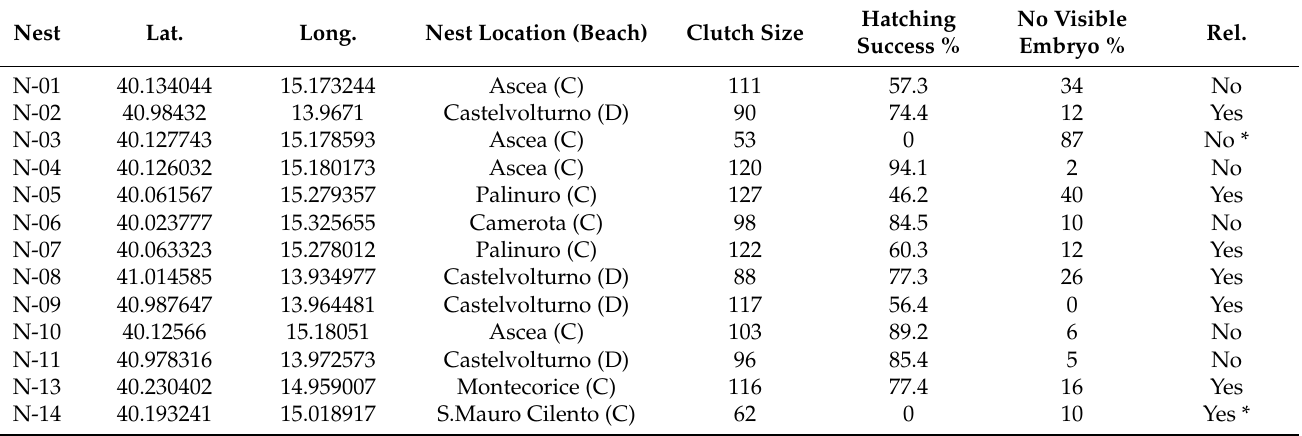
Table 1. Data on the loggerhead turtle nests sampled during the 2021 nesting season along the Campanian coast: Nest code; Nest coordinates latitude (Lat.) and longitude (Long.); Nest location (Beach); Clutch size ( n ); Hatching success (%); Proportion of unhatched eggs (%) with no visible embryo; Relocation